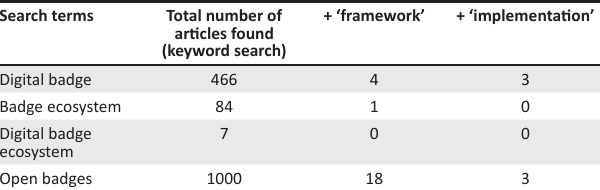
TABLE 3: Search terms used in keyword search strategy and returned